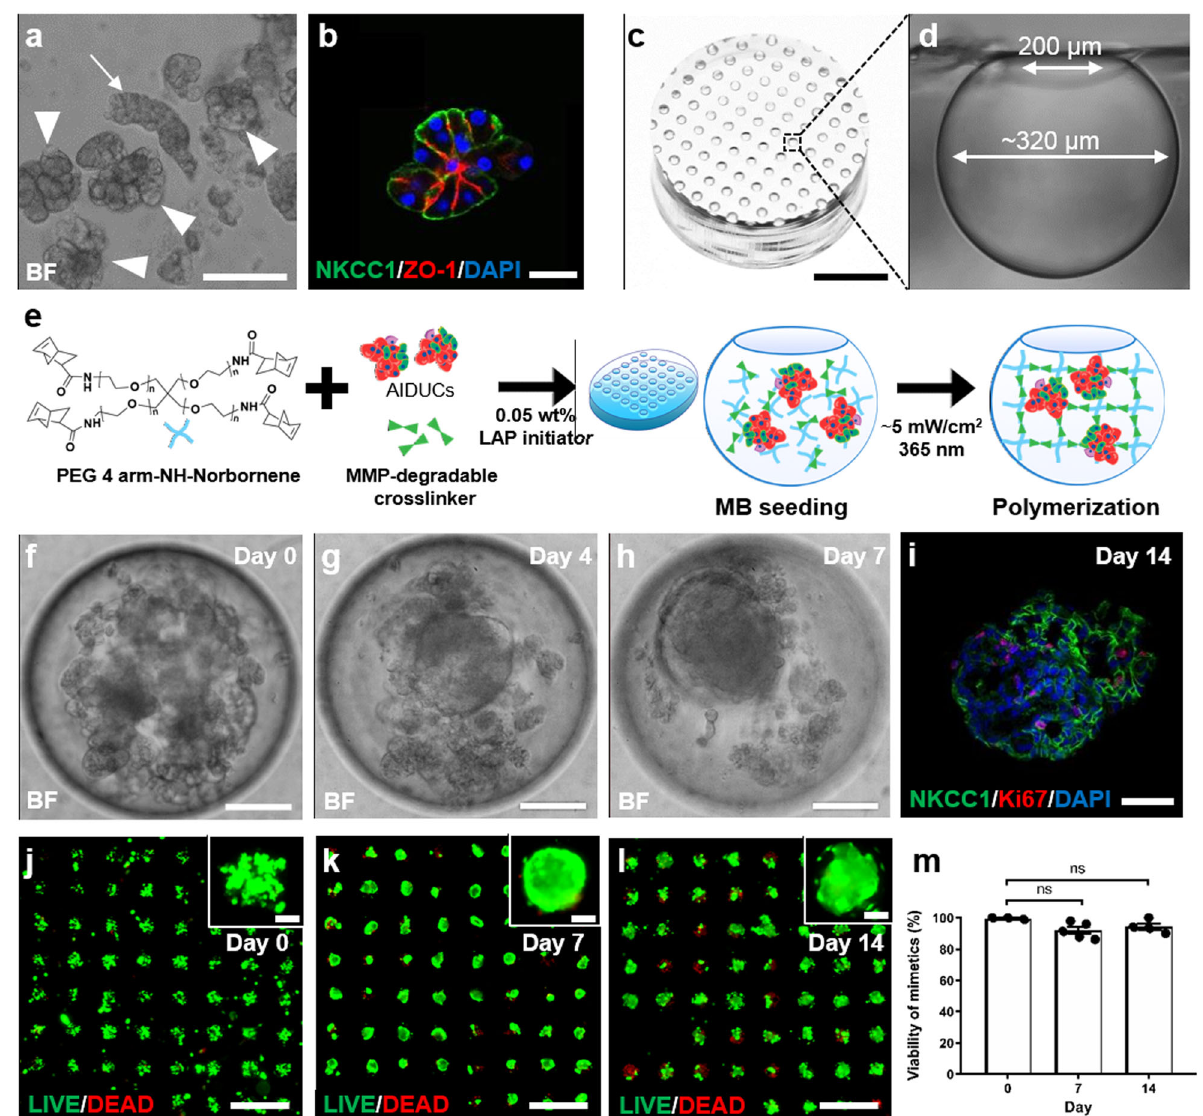
Fig. 1 Characterization of salivary gland MB-hydrogel culture system. a and b Representative images of a bright fi eld and b immunohistochemical staining of NKCC1 and ZO-1 in AIDUCs immediately post-isolation. Arrowheads in a indicate isolated acinar cell clusters. Arrow indicates a striated duct complex. c and d Image of c MB-chip (scale bar = 3 mm) and d a cross-sectional view of a single MB. e Schematic representation of hydrogel encapsulation of AIDUCs within MB-chips. f – h Bright fi eld images of AIDUC sphere formation in MB-chips at days 0, 4, and 7 (scale bars = 100 µ m). i IHC staining for Ki67, NKCC1, and DAPI within AIDUCs at day 14 (scale bar = 40 µ m). j – l Representative images of fl uorescent LIVE (green) and DEAD (red) staining of